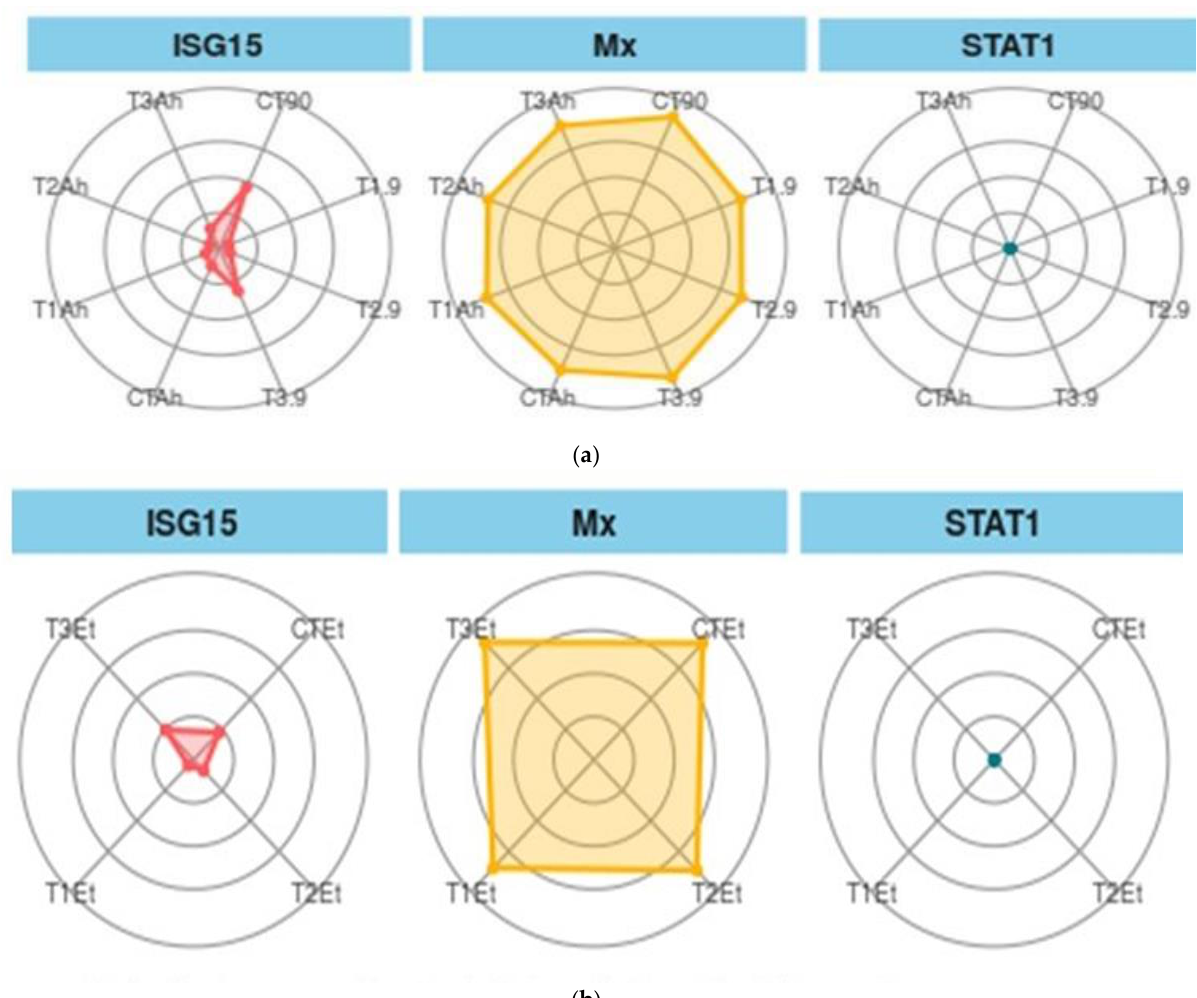
Figure 6. ( a ). Treatment biomarkers in the feeding trial followed by the challenge study. ( b ). Treatment biomarkers in the feeding trial followed by the challenge study. Here, CT, T1, T2, and T3 are the treatment groups, Mx, ISG15, and STAT1 are the targeted immunogenic genes, the suffix with 90 shows the feeding trial duration of 90 days, and the suffixes with Et and Ah represent the challenge study with two bacterial isolates, Ewardsiella tarda and Aeromonas hydrophila , for 10 days (90 – 100 days).